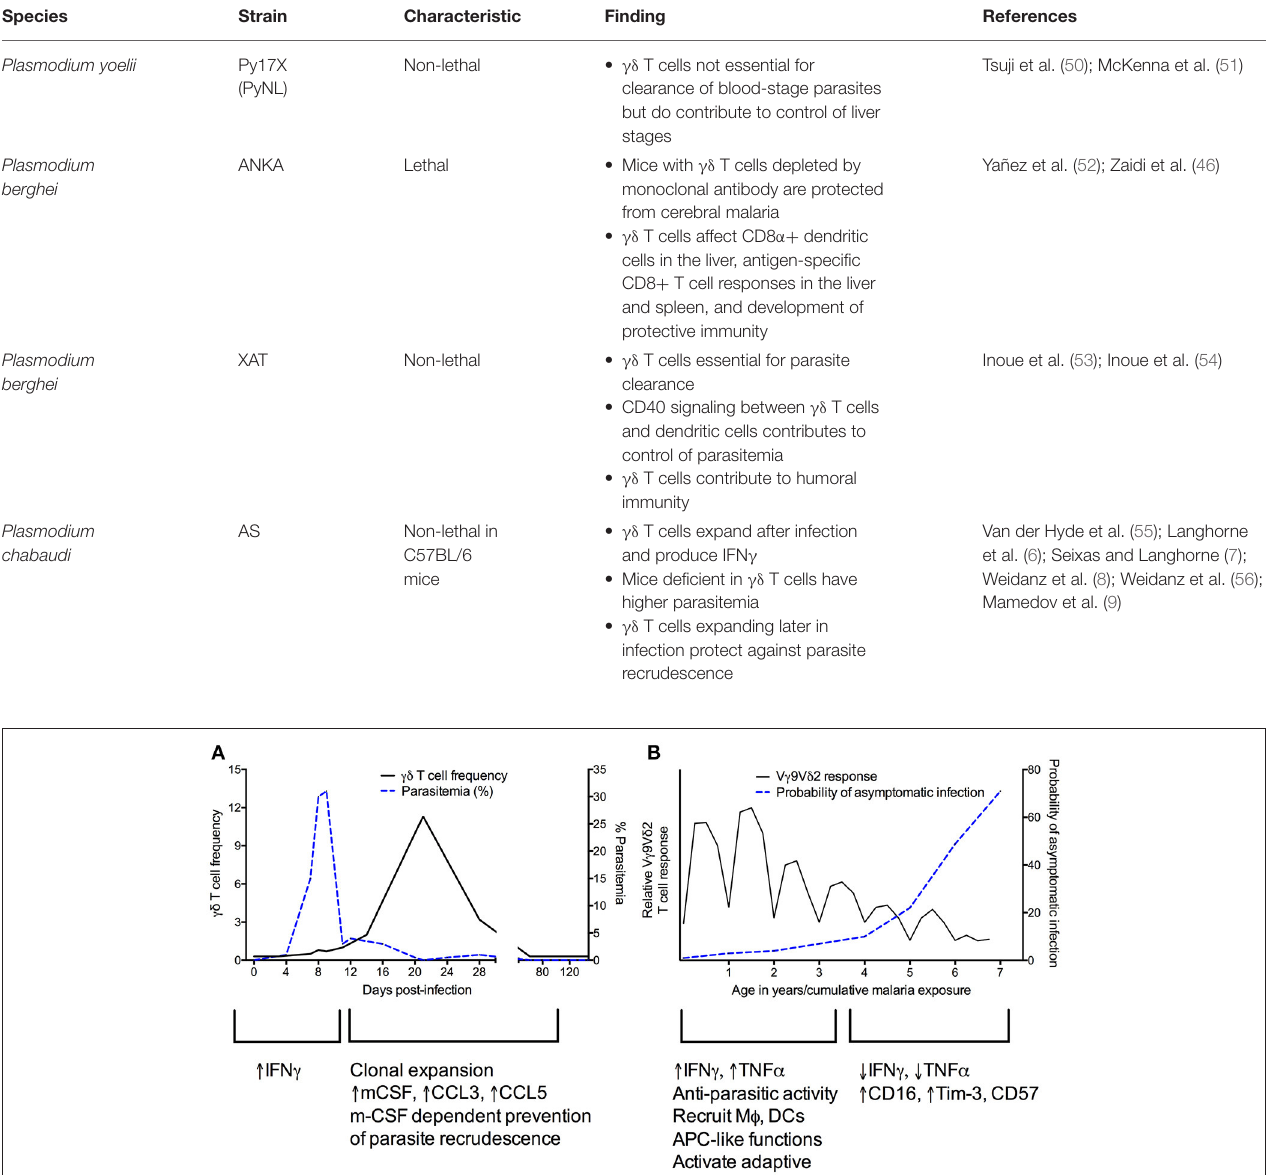
TABLE 2 | Associations between γδ T cells and protection in experimental Plasmodium infection models in mice. Species